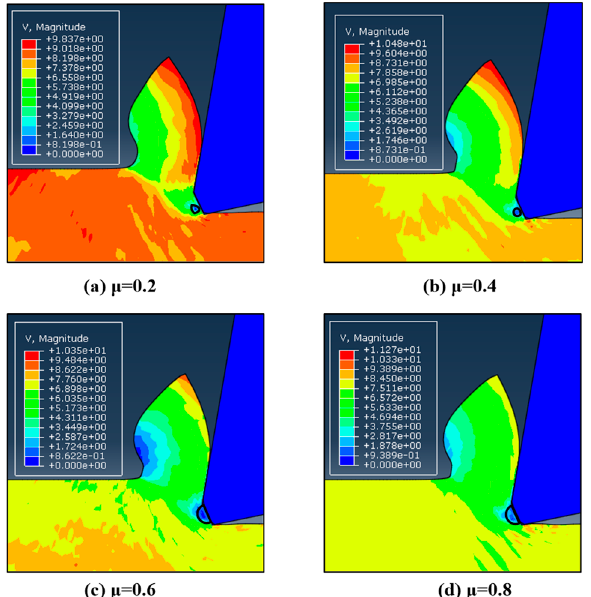
Figure 9. The distributions of velocity fields under different friction coefficient conditions.